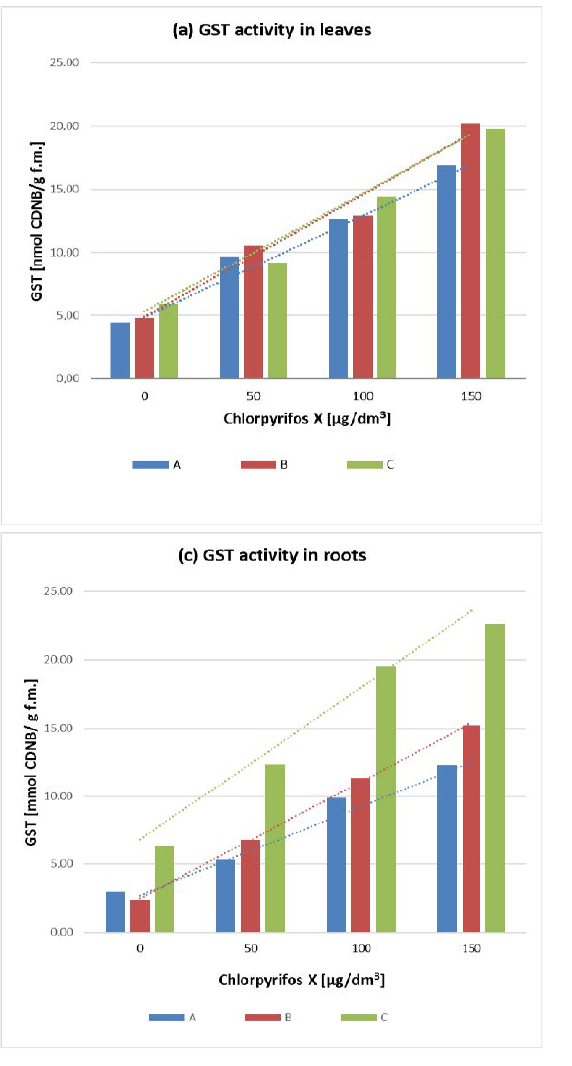
Figure 1. The enzyme activity changes: ( a ) GST activity in leaves; ( b ) GPX activity in leaves; ( c ) GST activity in roots; ( d ) GPX activity in roots in A—Canadian waterweed ( Elodea canadensis Michx.), B—needle spikerush ( Eleocharis acicularis L.), C—water mint ( Mentha aquatica L.).